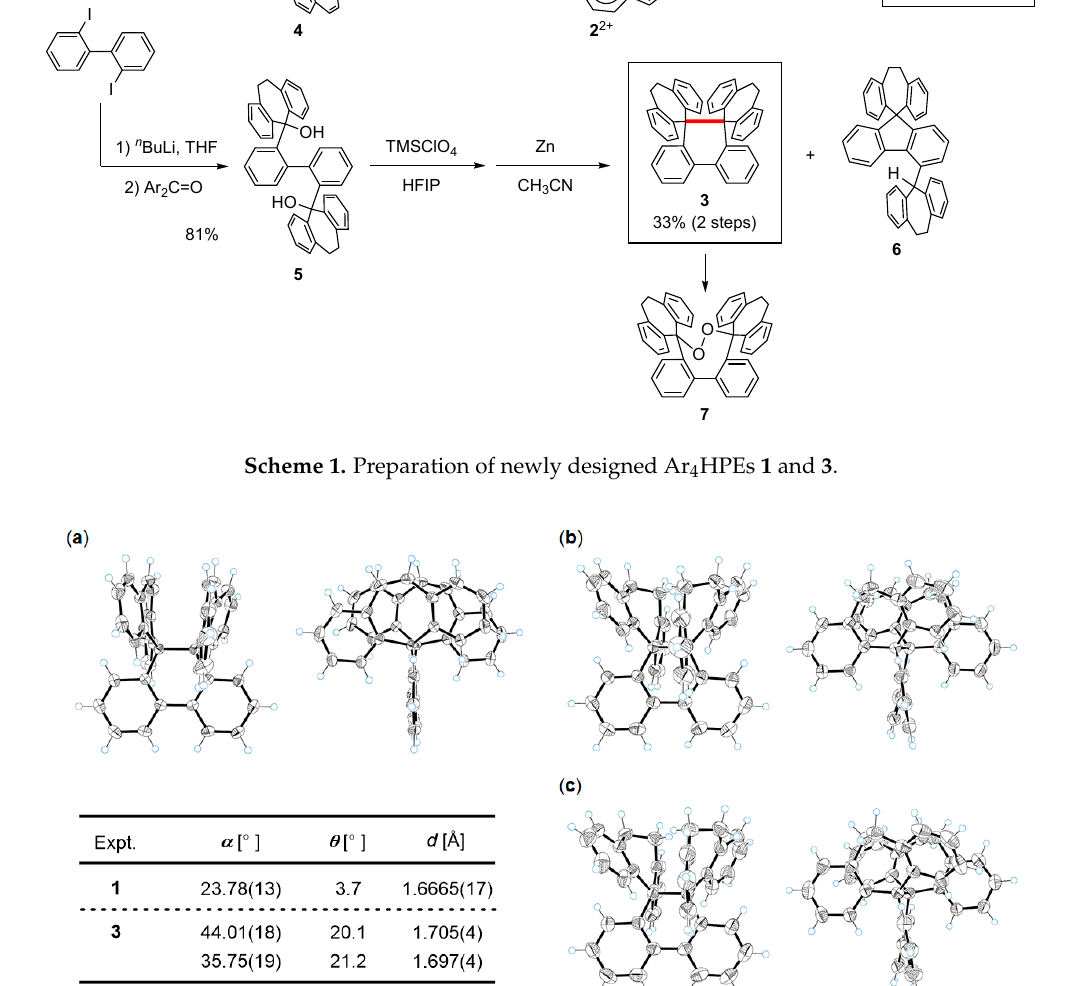
Figure 6. ORTEP drawings (left: front view, right: side view) of ( a ) 1 ; ( b ) 3 (mol-1) and ( c ) 3 (mol-2) at 150 K. Thermal ellipsoids are shown at the 50% probability level.